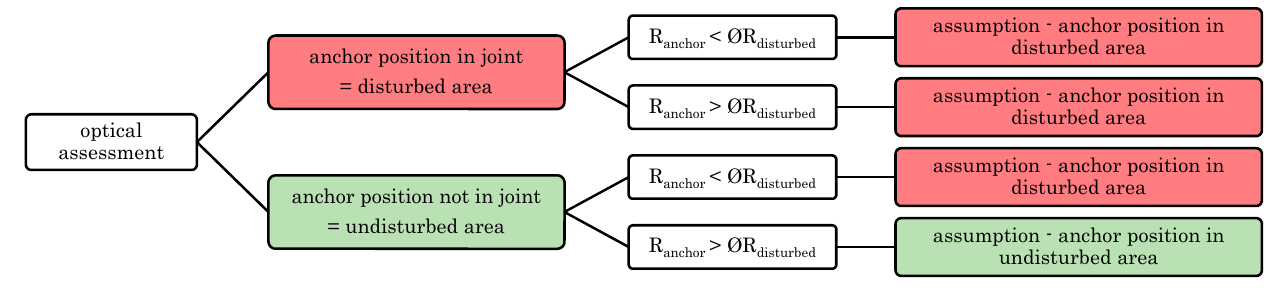
Figure 8. Flow chart for base material assessment by rebound hammer.